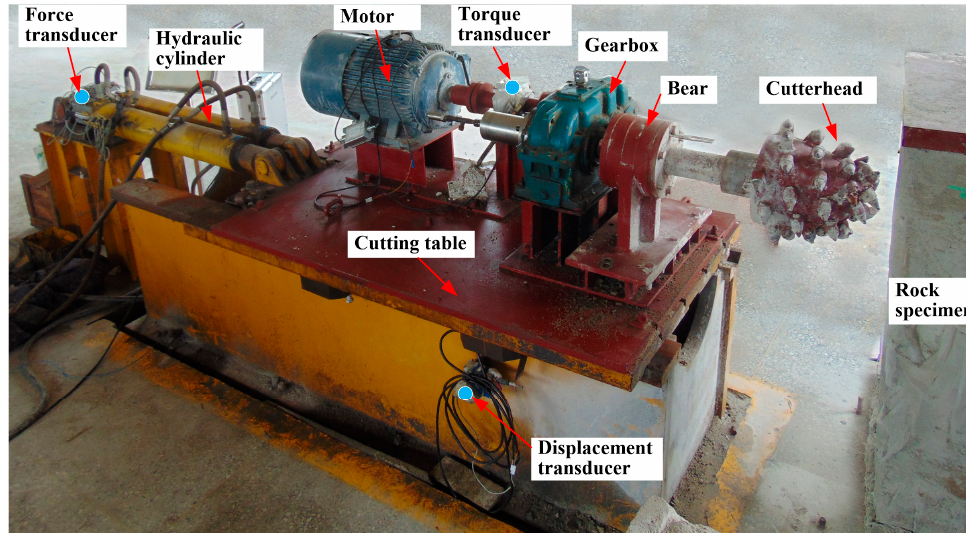
Figure 4. Rock-breaking test platform for the cutterhead.